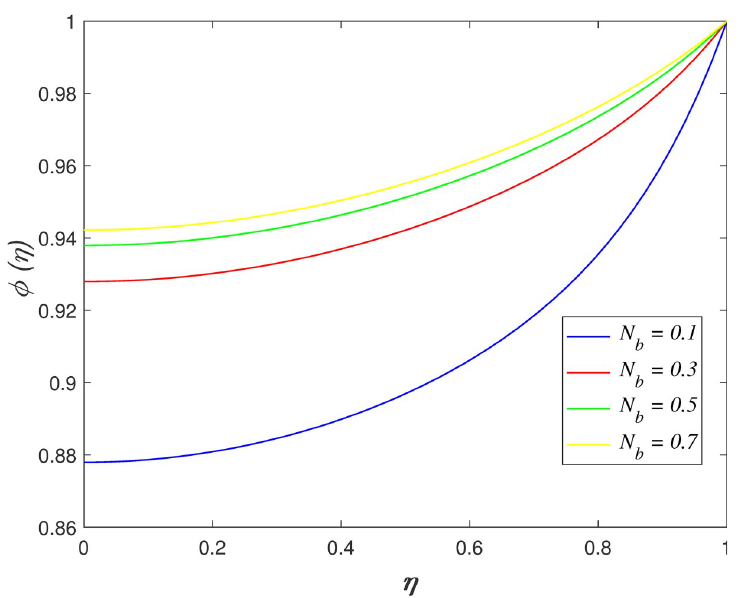
Fig 22. Impact of N